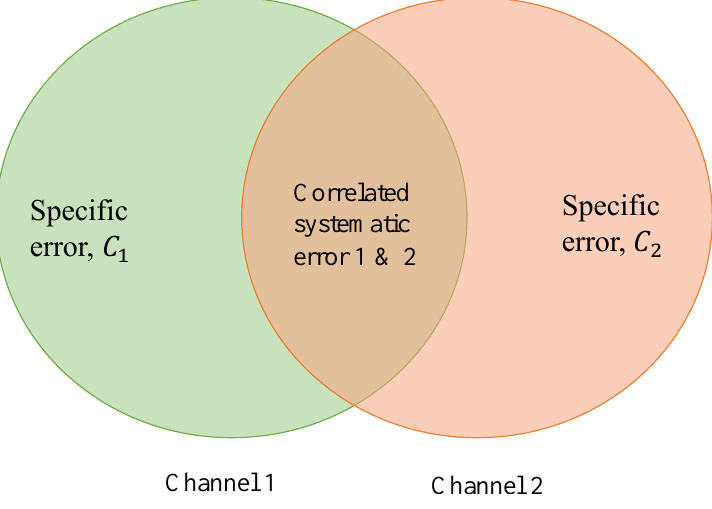
Figure 4. Specific and correlated systematic error in a parallel multi-channel